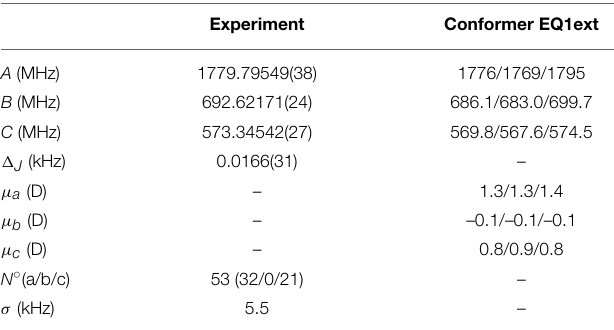
TABLE 1 | Experimentally obtained and calculated rotational constants and dipole moments for